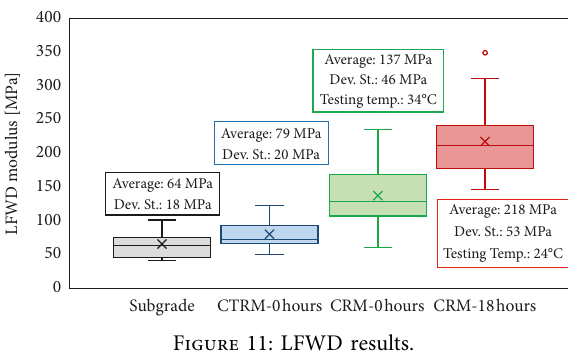
Figure 11: LFWD results.